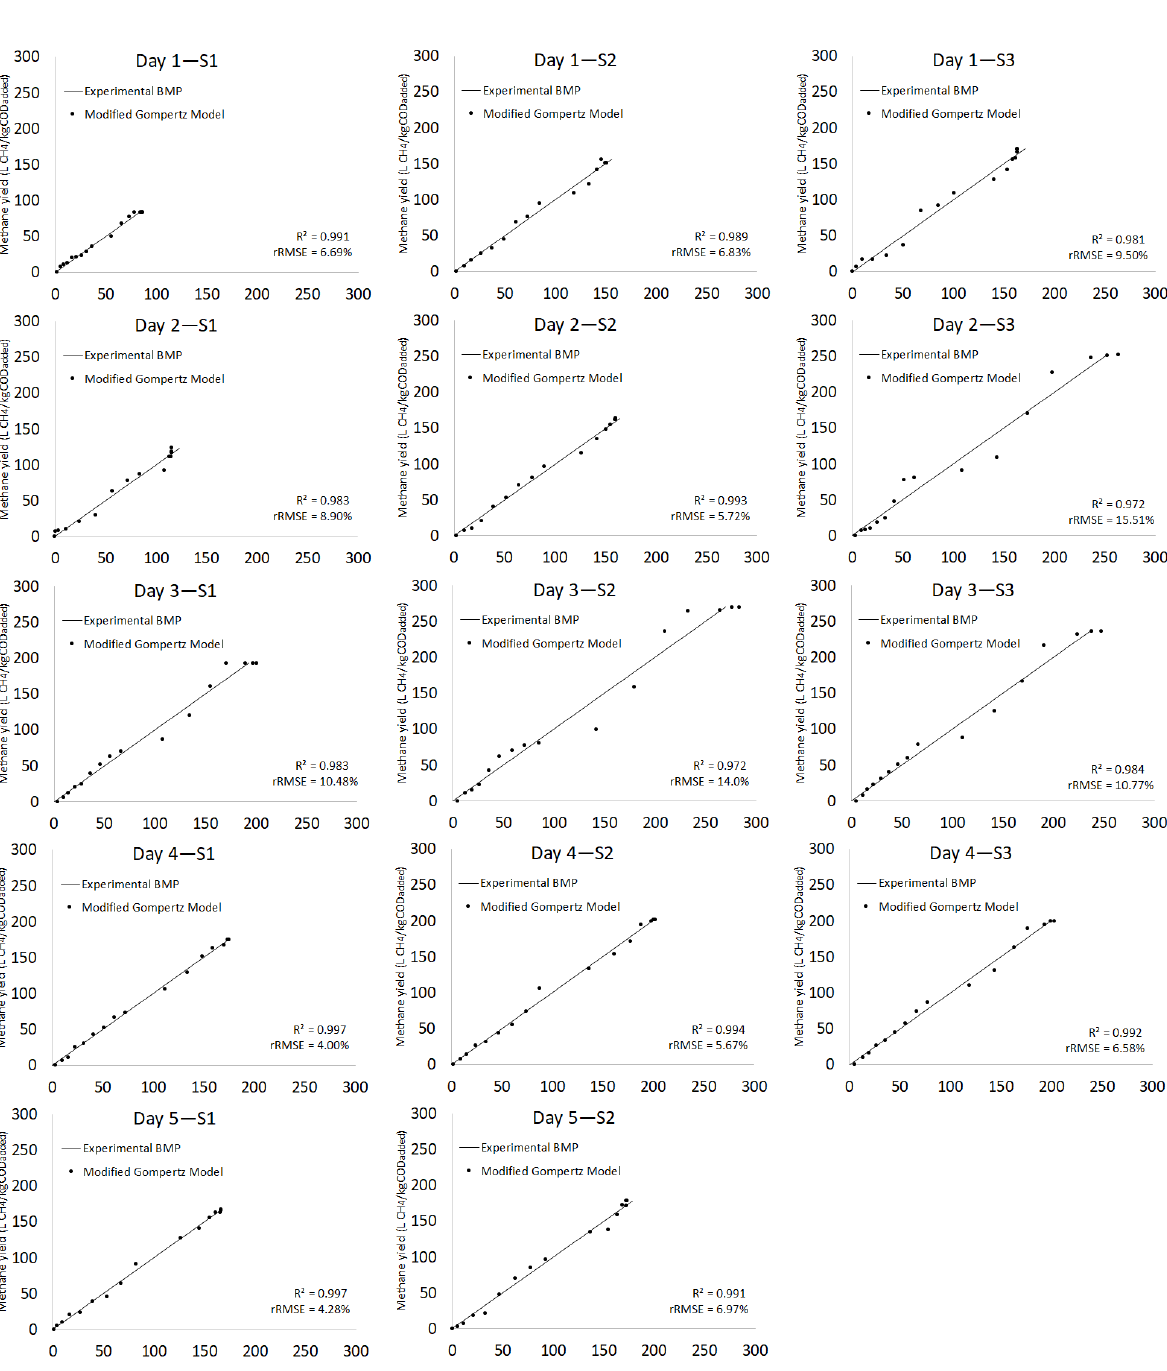
Figure 4. Experimental methane yields vs. predicted methane yields with Modified Gompertz model during the anaerobic digestion of rendering wastewater incubated in batch assays at 37 °C .